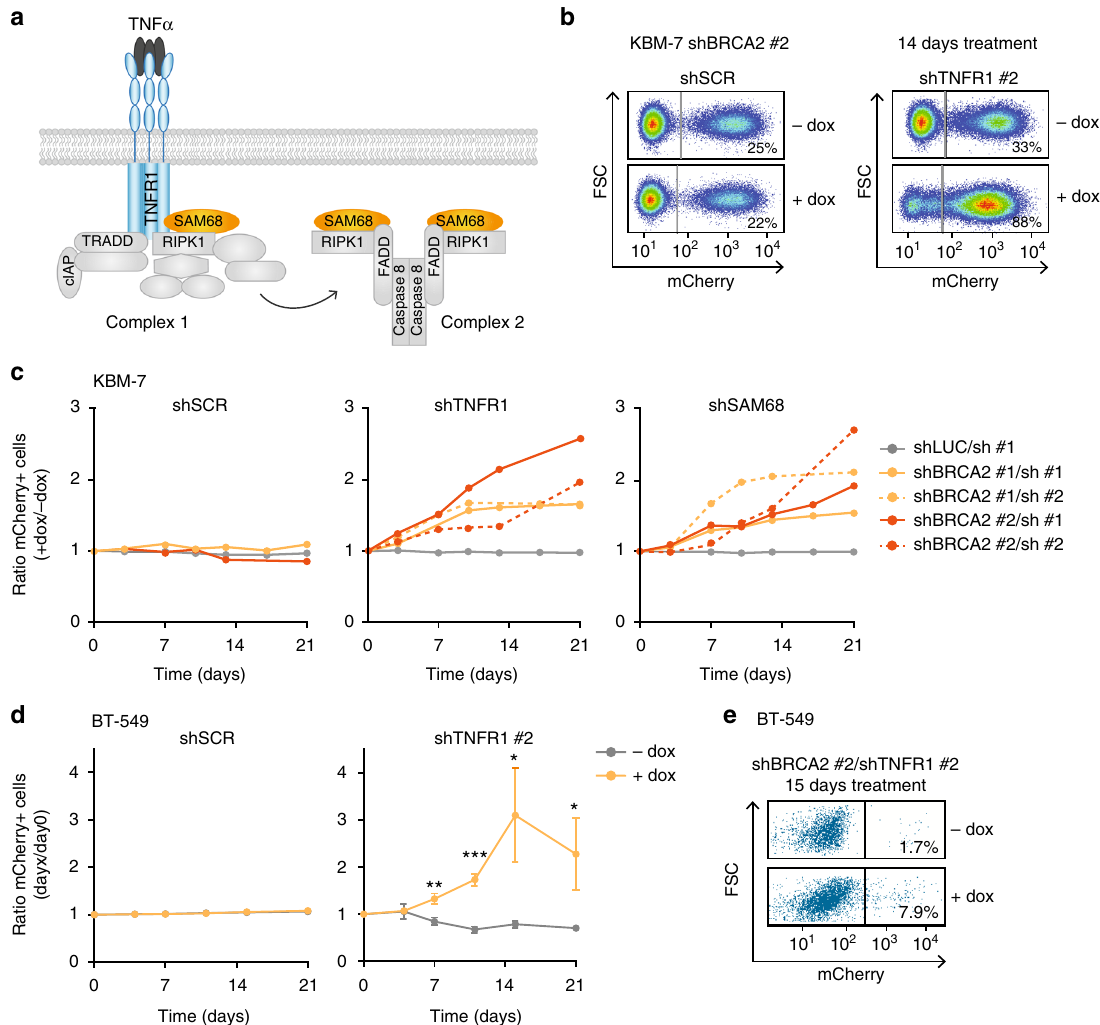
Fig. 2 Loss of TNFR1 and SAM68 rescues cellular viability in BRCA2-depleted cancer cells. a Schematic overview of TNFR1 complex formation upon TNF α binding, leading to cell survival (complex I) or delayed caspase activation and cell death (complex II). b Flow cytometry analysis of KBM-7-shBRCA2 #2 cells, additionally carrying indicated shRNA vectors with IRES-driven mCherry cassettes. Cells were treated with doxycycline for 14 days and percentages of mCherry-positive cells were measured. c Indicated KBM-7-shBRCA2 cells carrying mCherry shRNA cassettes targeting TNFR1, SAM68 or a control sequence ( ‘ SCR ’ ) were treated with or without doxycycline to induce BRCA2 shRNA expression. Percentages of mCherry-positive cells were measured every 3 or 4 days for 3 weeks after start of doxycycline treatment. Ratios of mCherry-positive cells in doxycycline treated cultures vs. untreated cultures are indicated. Per condition, at least 30,000 events were measured. d BT-549 cells, stably transduced with pLKO.tet.shBRCA2 #2, were infected with IRES mCherry shRNA vectors as for b . Cells were treated with or without doxycycline, and percentages of mCherry-positive cells were measured. Ratios of mCherry-positive cells at indicated time points vs. mCherry-positive percentages at day 0 are indicated. Error bars indicate s.d. of three independent experiments. P values were calculated using two-tailed Student ’ s t -test. * P < 0.05, ** P < 0.01 and *** P < 0.001. e Representative fl ow cytometry plots of